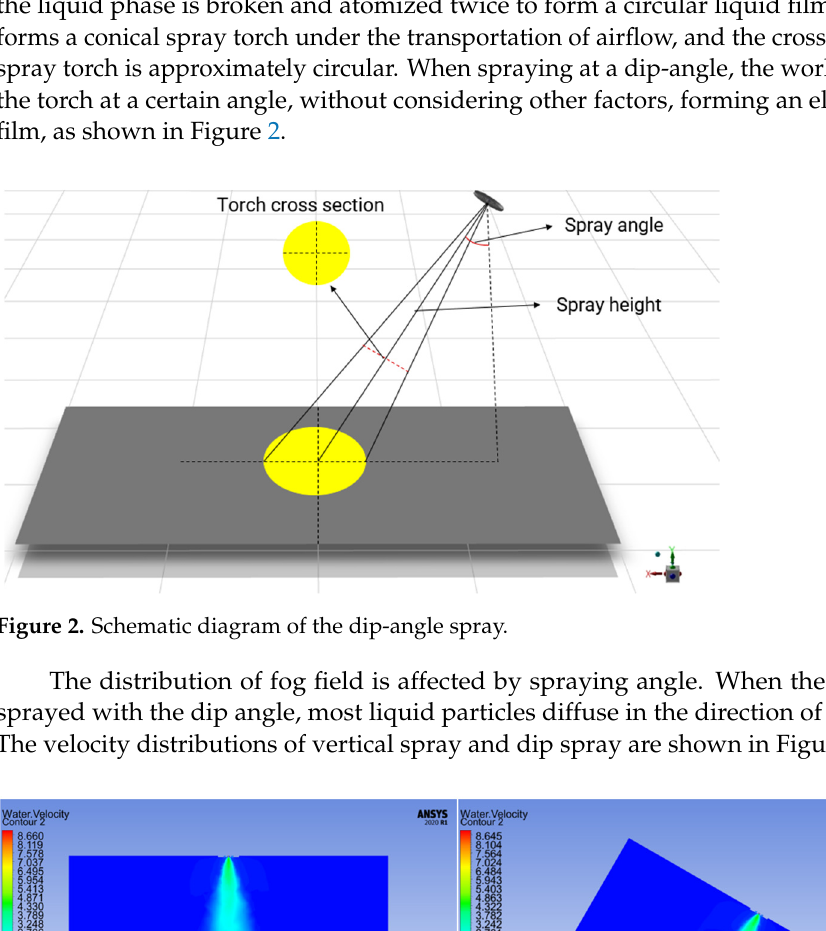
Figure 4. Velocity distribution of the fog field at 20mm from the workpiece.